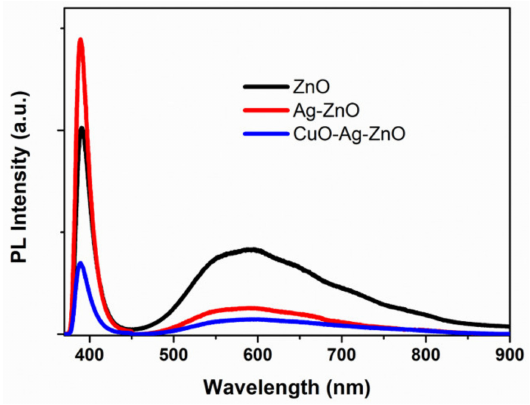
Figure 6. PL spectra of as-prepared samples.